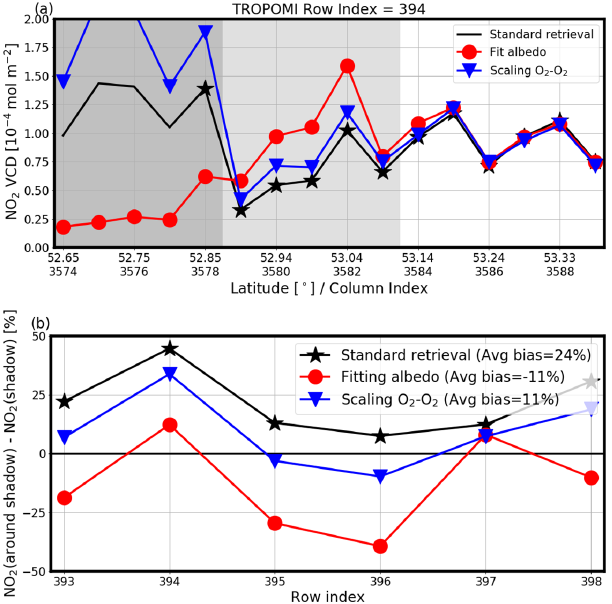
Figure 19. Comparison of the NO 2 VCDs using a standard retrieval algorithm and retrievals implementing the correction approaches discussed in Sect. 4.1.2 and 4.1.3. The data use TROPOMI measure- ments over the cloud shadow band for 30 December 2019. (a) The NO 2 retrieval based on three approaches as a function of latitude for TROPOMI row 394. The dark grey, light grey, and white re- gions represent the cloudy, shadow, and clean regions, respectively. (b) Difference of the NO 2 columns in the cloud shadow and that around shadow for the standard retrieval and the retrieval including a correction in the cloud shadow for row 393–398, and the average bias over all rows is given in the legend. See text for further